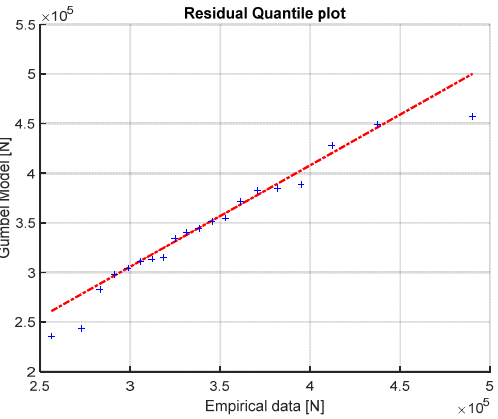
Figure 22. Residual quantile plot for maximum excursion values, Case 1, Minimum Diameter.